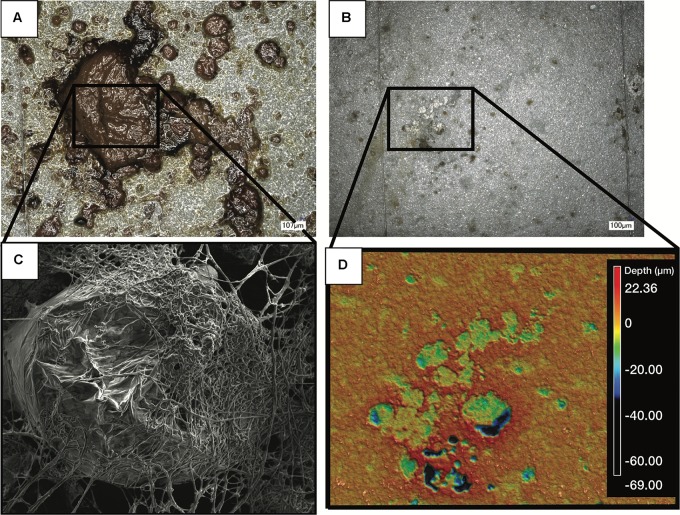
Images of a representative biofilm (A) on a witness coupon. After cleaning of the same biofilm, pitting corrosion was evident underneath the biofilm (B). SEM imaging of the coupon before cleaning revealed a large mass of fungal hyphae (C), while profilometry of the cleaned coupon showed clear pitting corrosion underneath the fungal biofilm (D).